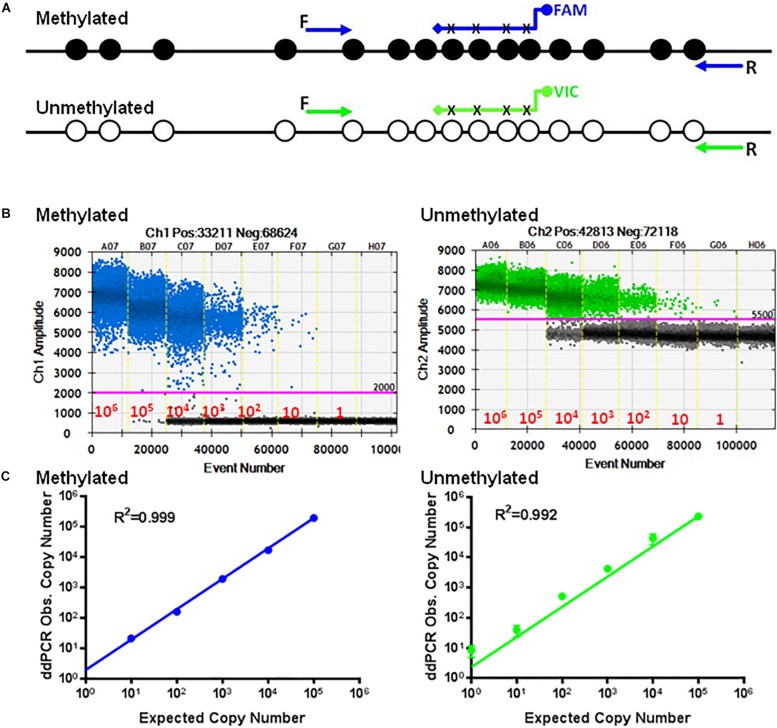
Standard curves of methylated and unmethylated FOXP3 TSDR. (A) Schematic illustration of the TSDR of FOXP3 showing the specific primer set for methylated CpGs with specific probes conjugated with FAM and the specific primer set for unmethylated CpGs with specific probes conjugated with VIC that interrogate six CpGs of TSDR. (B) ddPCR using serially diluted plasmids (106–1 copy/reaction). (C) Standard curves with linear regression analysis for methylated and unmethylated targets. The data shown are the average with standard deviation (SD) of three repeats.